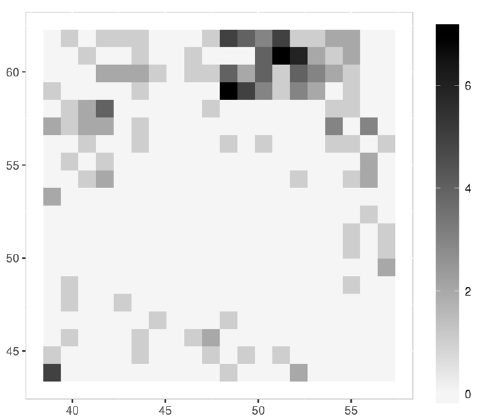
Figure 4. Density of tree seedlings between 50 cm and 150 cm height. Shades correspond to the number of individuals m −2 .